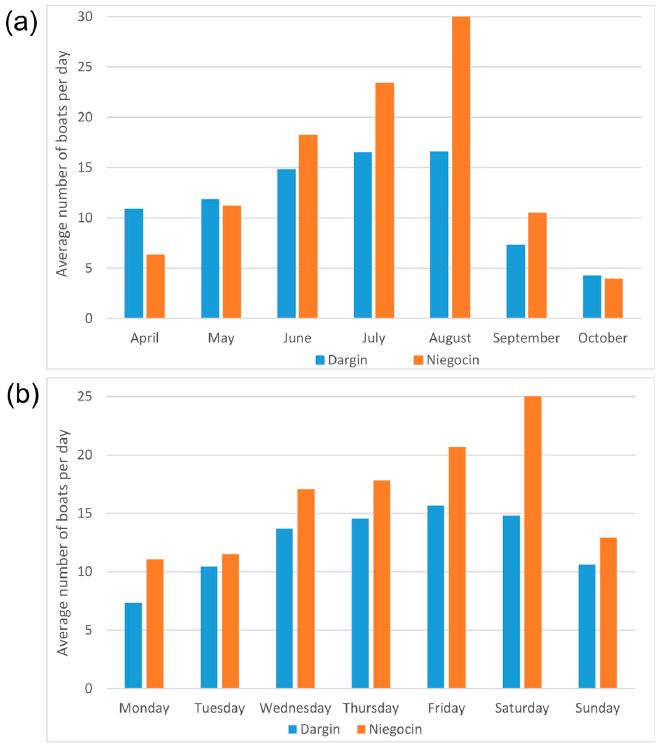
Figure 9 . Temporal distribution of detected recreational boats for the period 2015–2021: ( a ) monthly distribution, and ( b ) weekly distribution.